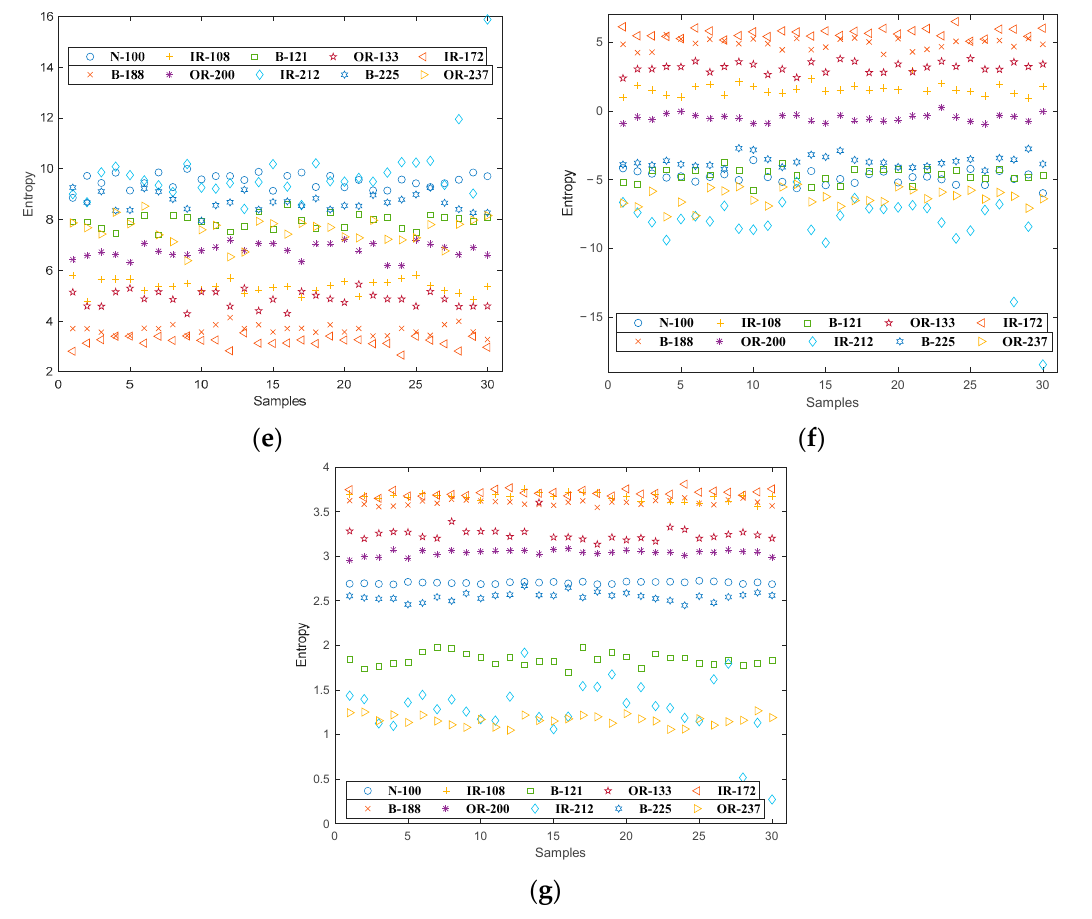
Figure 5. Single feature distribution of PSO-FrSlEn: ( a ) α = − 0.3; ( b ) α = 0.3; ( c ) α = − 0.2; ( d ) α = 0.2; ( e ) α = − 0.1; ( f ) α = 0.1; ( g ) α =